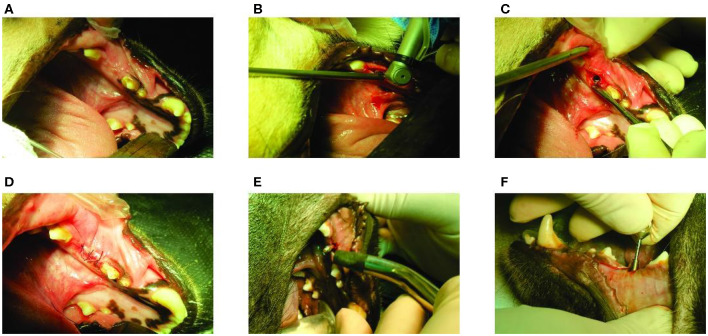
In-vivo experiments: (A) The extraction site after 8 weeks of healing; (B) Implant placement procedure; (C) Positioning of implant in the premolar area; (D) Suturing the implanted site using a 3–0 Polyglycolic Acid (PGA) suture; (E) Measuring implant stability through resonance frequency analysis (RFA) (Osstell® ISQ; Sweden); and (F) Mounting straight abutment (Bionic®, dental implants, Nickashtasia Inc.; Ti6Al4V, 4.5 mm of diameter, 2 mm of gingival height, & 7 mm of height) on the implant.